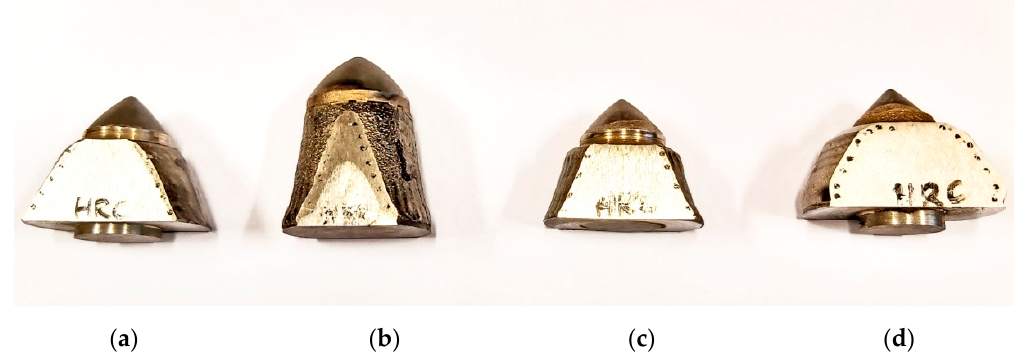
Figure 14. Examples of samples prepared for padding weld hardness tests from tested picks: ( a ) pick for shaft-boring roadheaders (Figure 11d); ( b ) pick for shaft-boring roadheaders (Figure 11e); ( c ) pick for shaft-boring roadheaders (Figure 11f); ( d ) hardfaced pick for roadheaders (Figure 11b). Table 7. Summary of the results of material tests for individual picks. List of